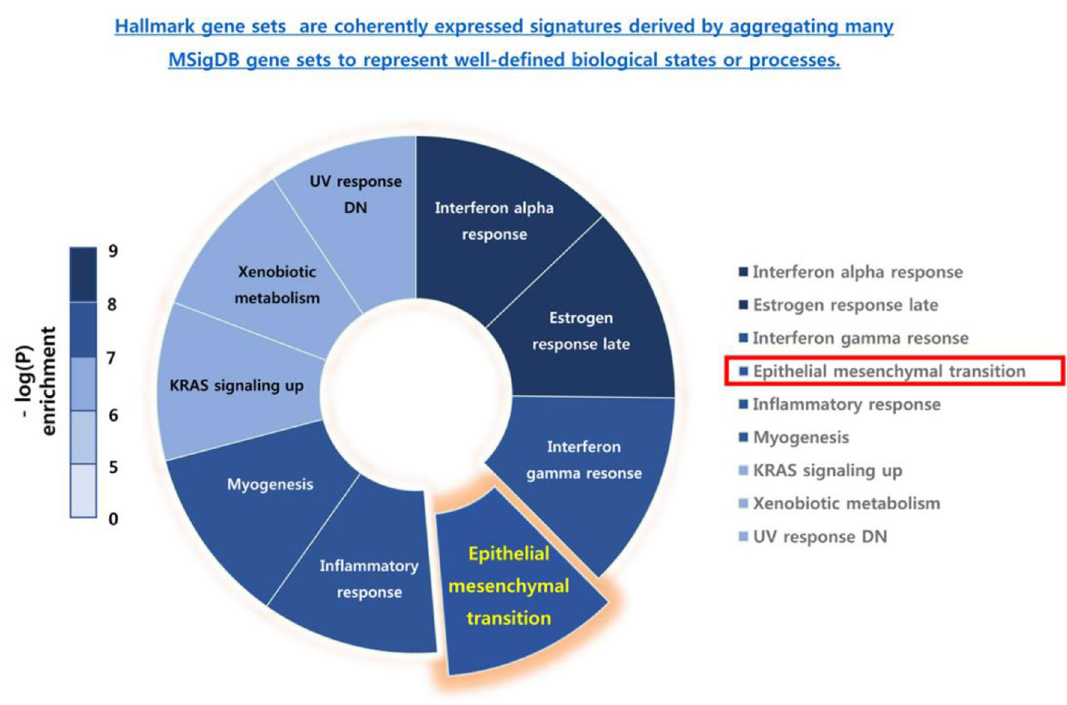
Figure 3. Hallmark wheels of genomic/transcriptomic and full integrated datasets, related to Fig. 4. Hallmark wheel showed enrichment of hallmark pathways when the transcriptional and genomic information is